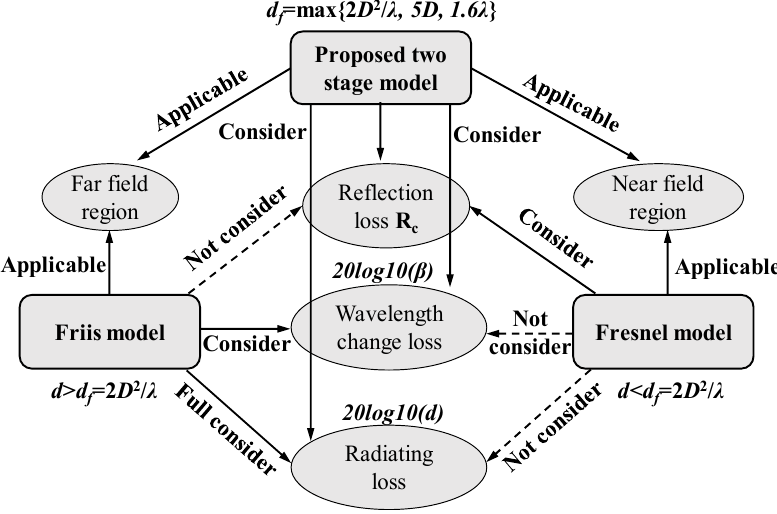
Figure 3. Comparison among the proposed model, the Friis model and the Fresnel model in a qualitative way.